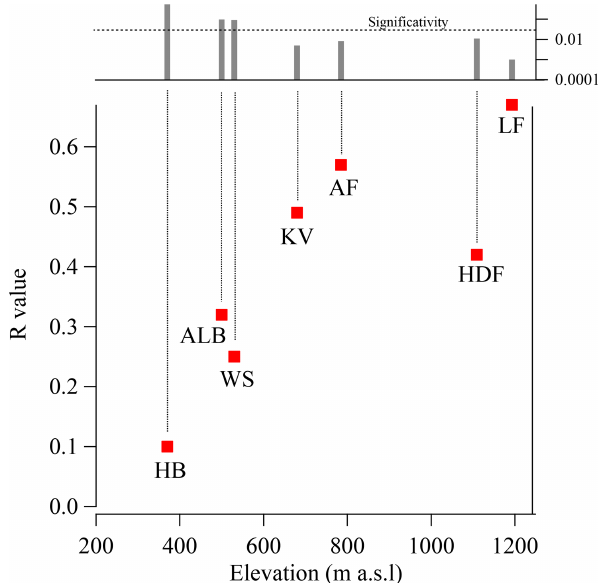
Figure 7. The correlation coefficient between the oxygen isotope ratio ( δ 18 O) and log ( Na load ) increases with elevation. The left axis represents the correlation coefficient ( R ) between log ( Na load ) and δ 18 O, using the entire dataset for each snowpit (i.e. all layers have been used for the statistical correlation). The x axis indicates the altitude of the snowpit. The upper panel shows the p value: correla- tions have been considered statistically significant if p < 0 .